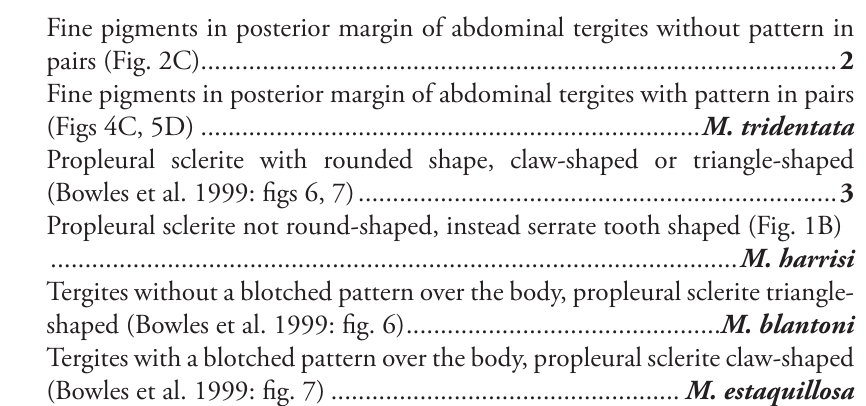
Phallus apically with two pairs of elongate spines ........................................ 5 – Phallus apically without spines (Harris and Holzenthal 1997: fig. 6D, E; Bueno-Soria and Barba-Álvarez 1999: fig. 8) .............................................. 6 5 Phallus apically with a pair of elongate, weak spines laterally, pair of thin spines mesally and subapically with a pair of spicule bearing tergites (Harris and Holzenthal 1997: fig. 5D, E) ............................................... M. tamaza – Phallus apically with two pairs of elongate spines, without a subapical pair of spicules bearing tergites (Harris and Holzenthal 1997: fig. 8D, E) ................ ............................................................................................... M. tridentata 6 Phallus subapically with a pair of lateral spines, with ejaculatory duct emerg- ing between spines (Harris and Holzenthal 1997: fig. 6E)............. M. trifida – Phallus subapically with a pair of thin, elongate spines laterally, without ejac- ulatory duct emerging between spines (Bueno-Soria and Barba-Álvarez 1999: fig. 4) ............................................................................................... M. rara Key to known females of Mejicanotrichia 1 Bursa copulatrix with two membranous lobes (Fig. 3D) ............................. 2 – Bursa copulatrix with one membranous lobe (Harris and Holzenthal 1997: fig. 4D) ....................................................................................... M. tamaza 2 Bursa copulatrix with keyhole-structure, with keyhole-shaped sclerite mesally (Fig. 3D)..................................................................................................... 3 – Bursa copulatrix without keyhole-structure, with oval sclerite mesally (Harris and Holzenthal 1997: fig. 4F) .............................................. M. estaquillosa 3 Bursa copulatrix with shield-shaped sclerite (Fig. 3D) .................. M. harrisi – Bursa copulatrix without shield-shaped sclerite (Harris and Holzenthal 1997: fig. 4A) ...................................................................................... M. blantoni Key to known larvae of Mejicanotrichia 1 Fine pigments in posterior margin of abdominal tergites without pattern in pairs (Fig. 2C) ............................................................................................. 2 – Fine pigments in posterior margin of abdominal tergites with pattern in pairs (Figs 4C, 5D) ......................................................................... M. tridentata 2 Propleural sclerite with rounded shape, claw-shaped or triangle-shaped (Bowles et al. 1999: figs 6, 7) ...................................................................... 3 – Propleural sclerite not round-shaped, instead serrate tooth shaped (Fig. 1B) .................................................................................................... M. harrisi 3 Tergites without a blotched pattern over the body, propleural sclerite triangle- shaped (Bowles et al. 1999: fig. 6) .............................................. M. blantoni – Tergites with a blotched pattern over the body, propleural sclerite claw-shaped (Bowles et al. 1999: fig. 7) ................................................... M.